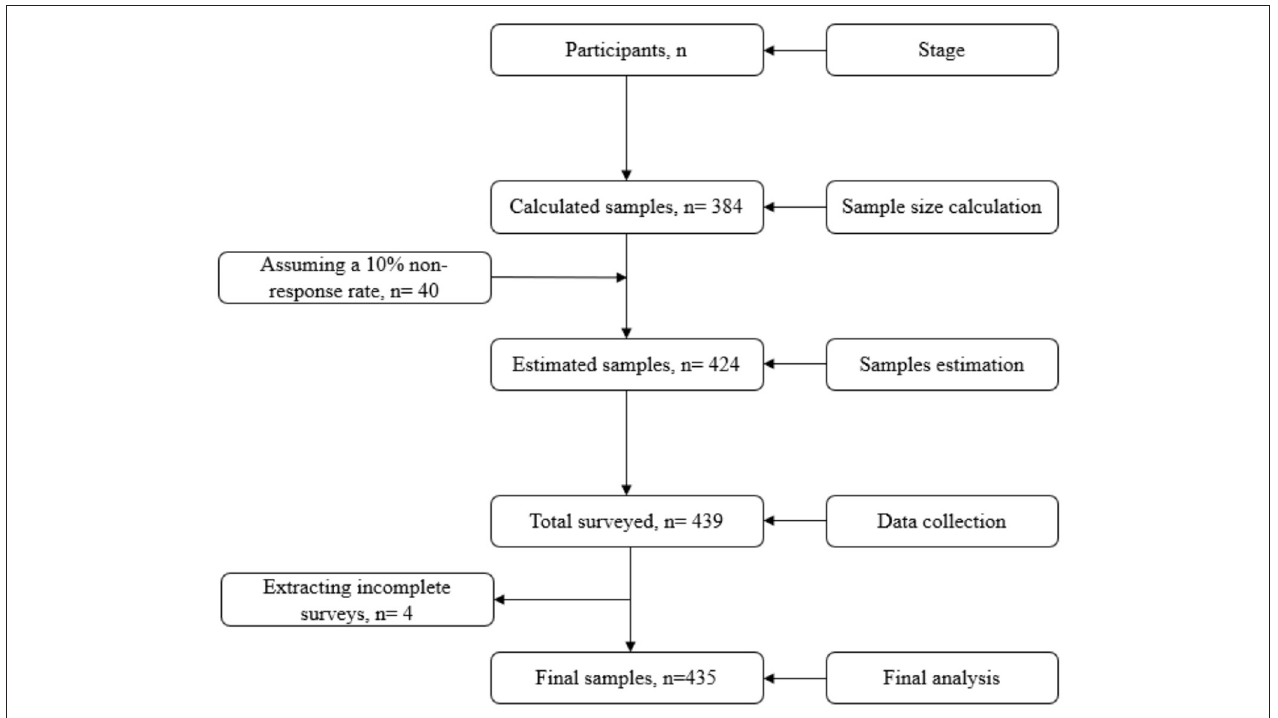
FIGURE 1 | Inclusion of the